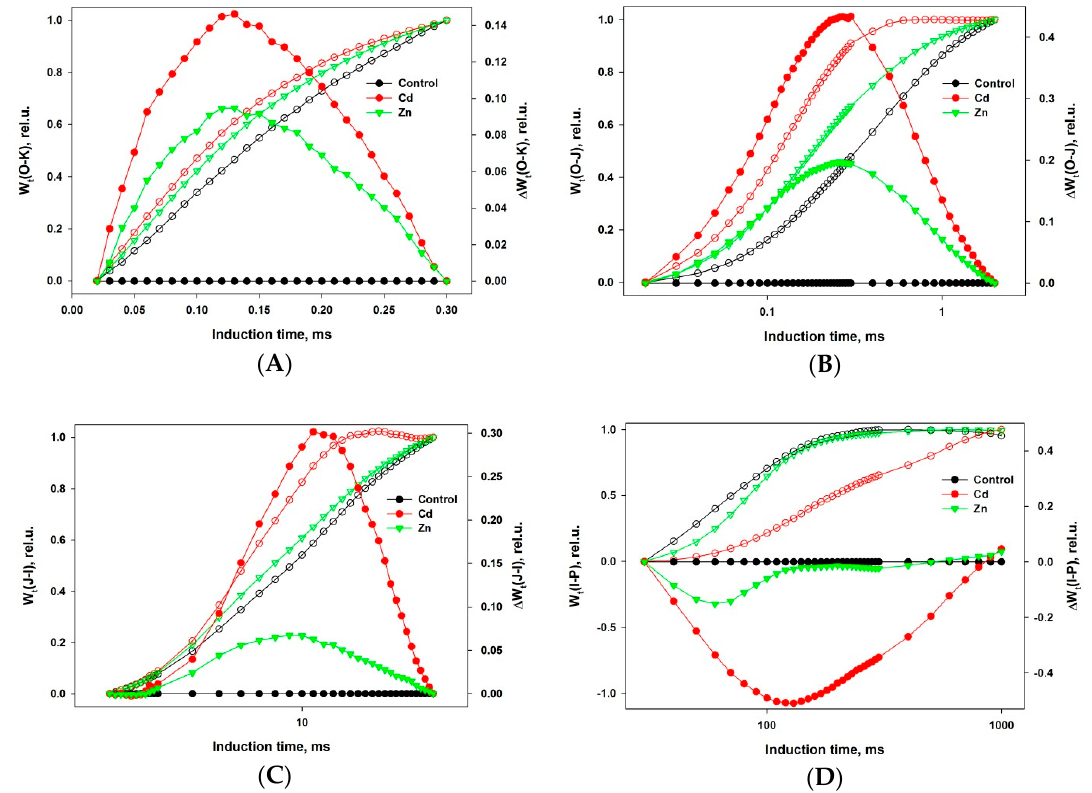
Figure 2. Combined graphs of differential curves (filled circles) and their corresponding double normalized chlorophyll fluorescence signal (empty circles): ( A ) from O to K (L band), ( B ) from O to J (K band), ( C ) from J to I (H), and ( D ) from I to P (G band). All these transients are constructed from the corresponding values of the curves shown in Figure 1A and the series designation is the same: control plants (black), exposed to Cd (red), and to Zn (green). There is a statistically significant difference for the maximal values of the differential curves of exposed plants compared to the control with p < 0.05.